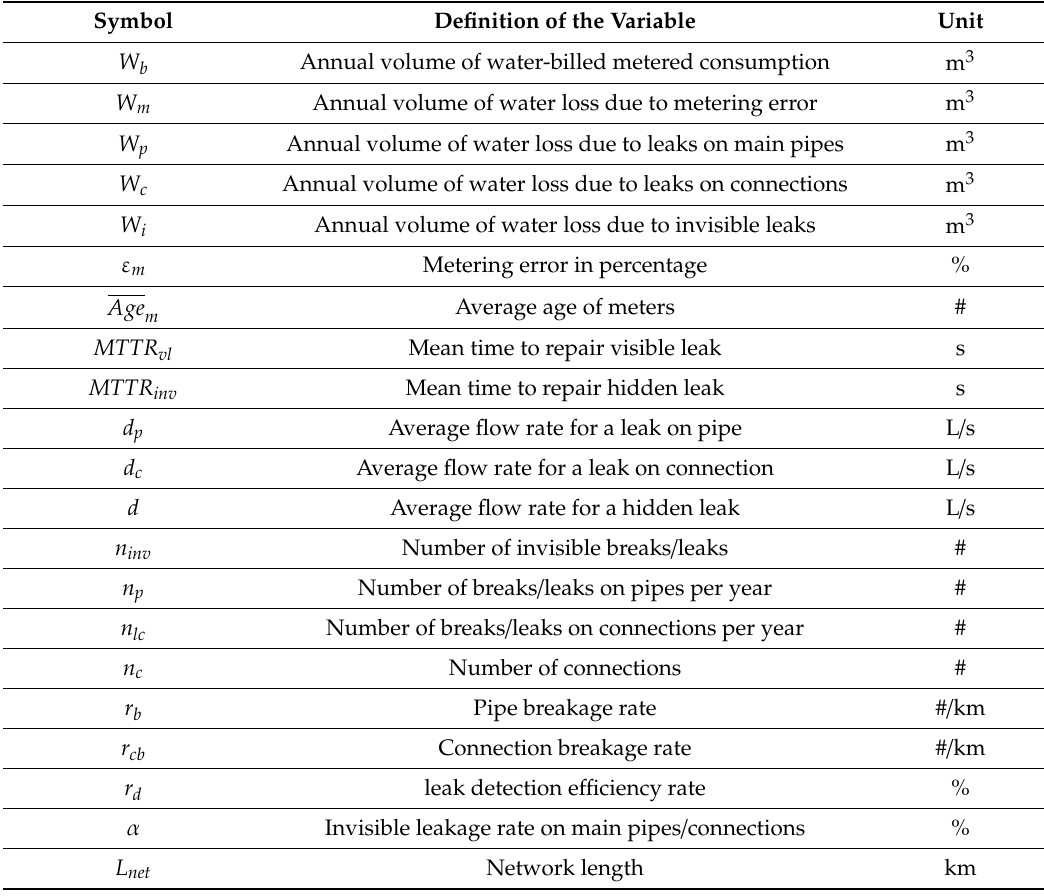
Table 2. List of variables required for hydraulic